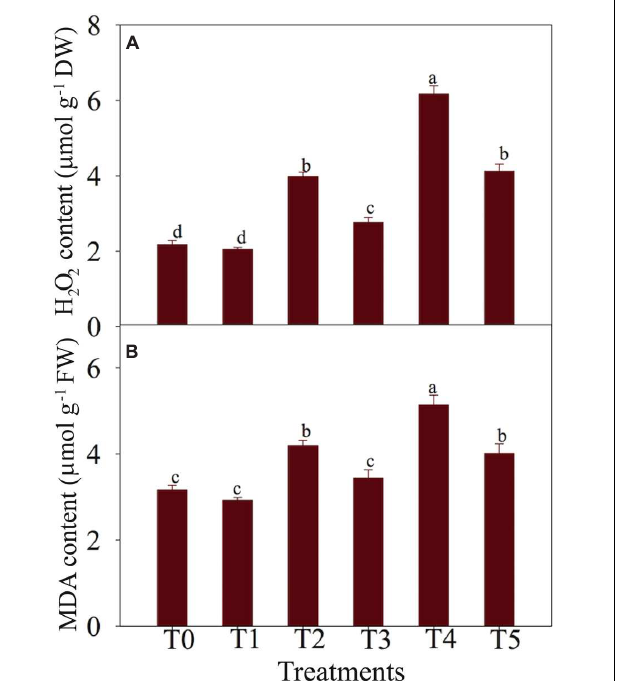
FIGURE 2 | Effects of NO on (A) hydrogen peroxide (H 2 O 2 ) content and (B) malondialdehyde (MDA) content in leaves of chickpea plants under salt stress. Data presented are the means ± SEs ( n = 5). Different letters indicate significant difference ( P ≤ 0.05) among the treatments. T0 (control) = 0 mM NaCl + 0 µ M SNAP; T1 = 0 mM NaCl + 50 µ M SNAP; T2 = 50 mM NaCl + 0 µ M SNAP; T3 = 50 mM NaCl + 50 µ M